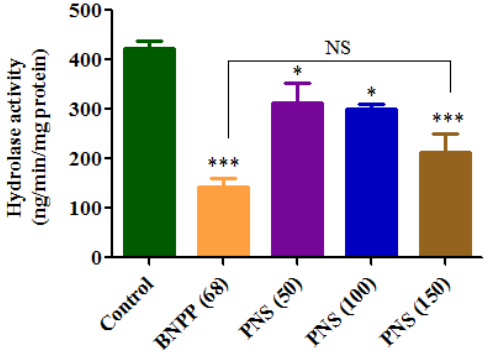
Figure 7. Hydrolysis of aspirin (ASA) in Caco-2 cells homogenates treated with various concentrations of Panax notoginseng saponins (PNS). Cell homogenates were prepared from Caco-2 cell monolayers and then diluted with 50 mM HEPES buffer (pH 7.4) at 1.2 mg/mL. Hydrolysis of ASA (1.8 μg/mL) in cell homogenates were carried out in the presence of PNS. No significance (NS) was detected between BNPP (68 μg/mL) and PNS (150 μg/mL). Data were presented as mean ± SD ( n = 3). *, and *** denoted results significantly different from that of the control group ( p < 0.05, p < 0.001).